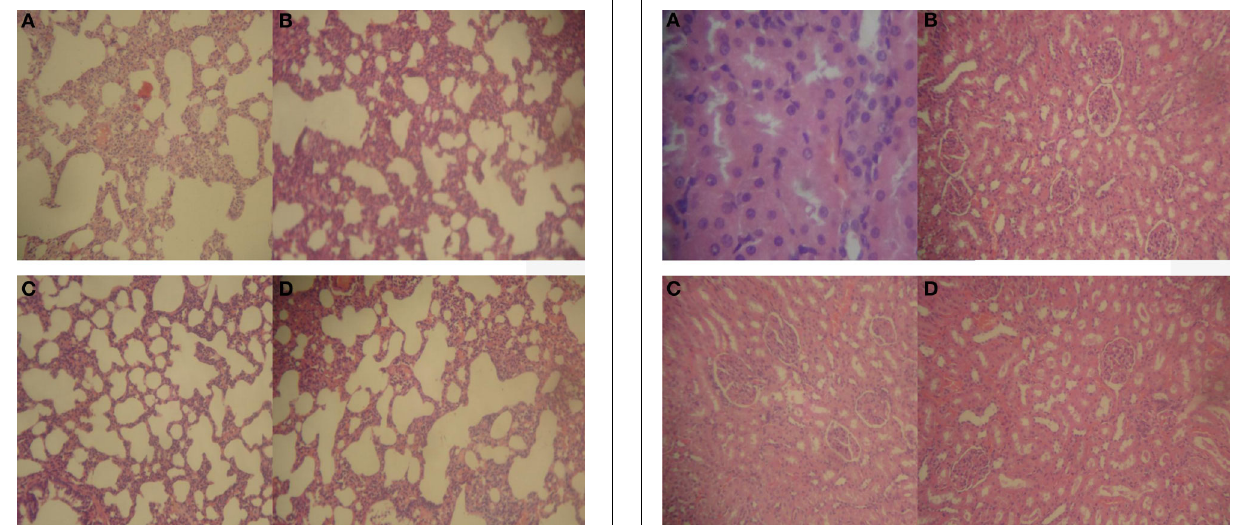
FIGURE 3 | Representative sections of rat kidneys in respect of 60 days treatment. (A) Normal rat kidney showing regular tubular cells with normal nuclei; (B) 20mg/kg/day HLE-FP-treated rat kidney showing glomeruli with capillary vascular congestion; (C) 100mg/kg/day HLE-FP-treated rat kidney showing regular glomeruli with scattered localized hemorrhage; and (D) 500mg/kg/day HLE-FP-treated rat kidney showing regular glomeruli and tubules with moderate vascular congestion ( × 100, × 400 magnification).